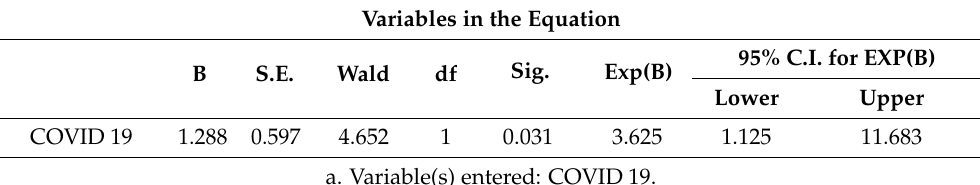
Table 6. Binary logistic regression evaluating the relationship between COVID-19 and mortality. Variables in the Equation